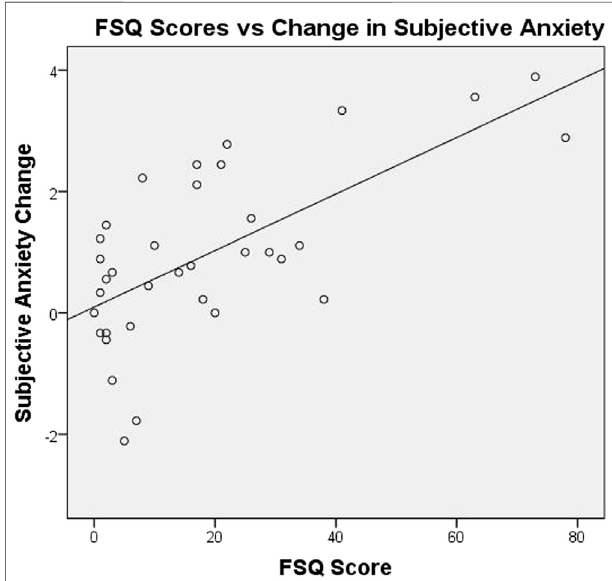
FIGURE 6| Scatter plot for FSQ scoresvs changes in subjective anxiety (Mean of self reported anxiety across scenarios - baseline self report).